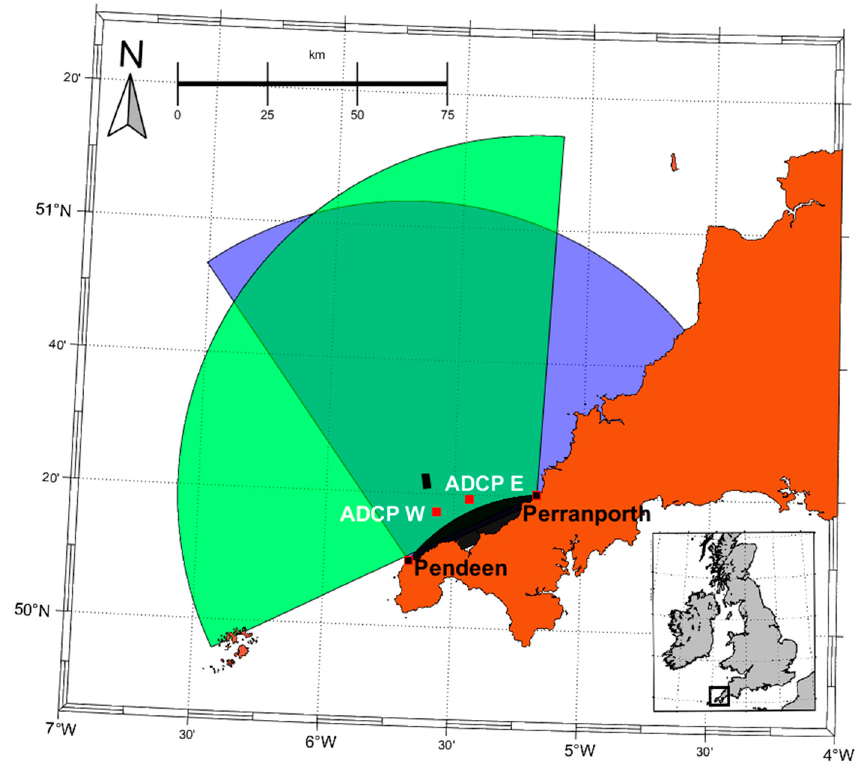
Figure 1. Map showing the locations of the HF radars at Pendeen and Perranporth and their coverage. The red squares represent ADCP west and east. The rectangle represents the WaveHub test site.